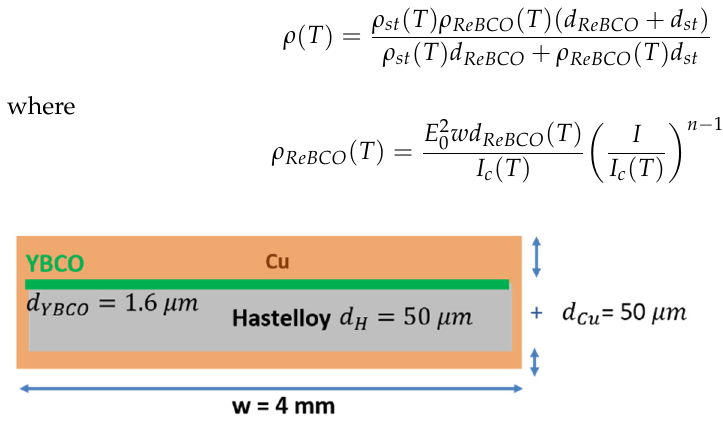
Figure 1. A simplified cross-sectional view of the ReBCO tape conductor.